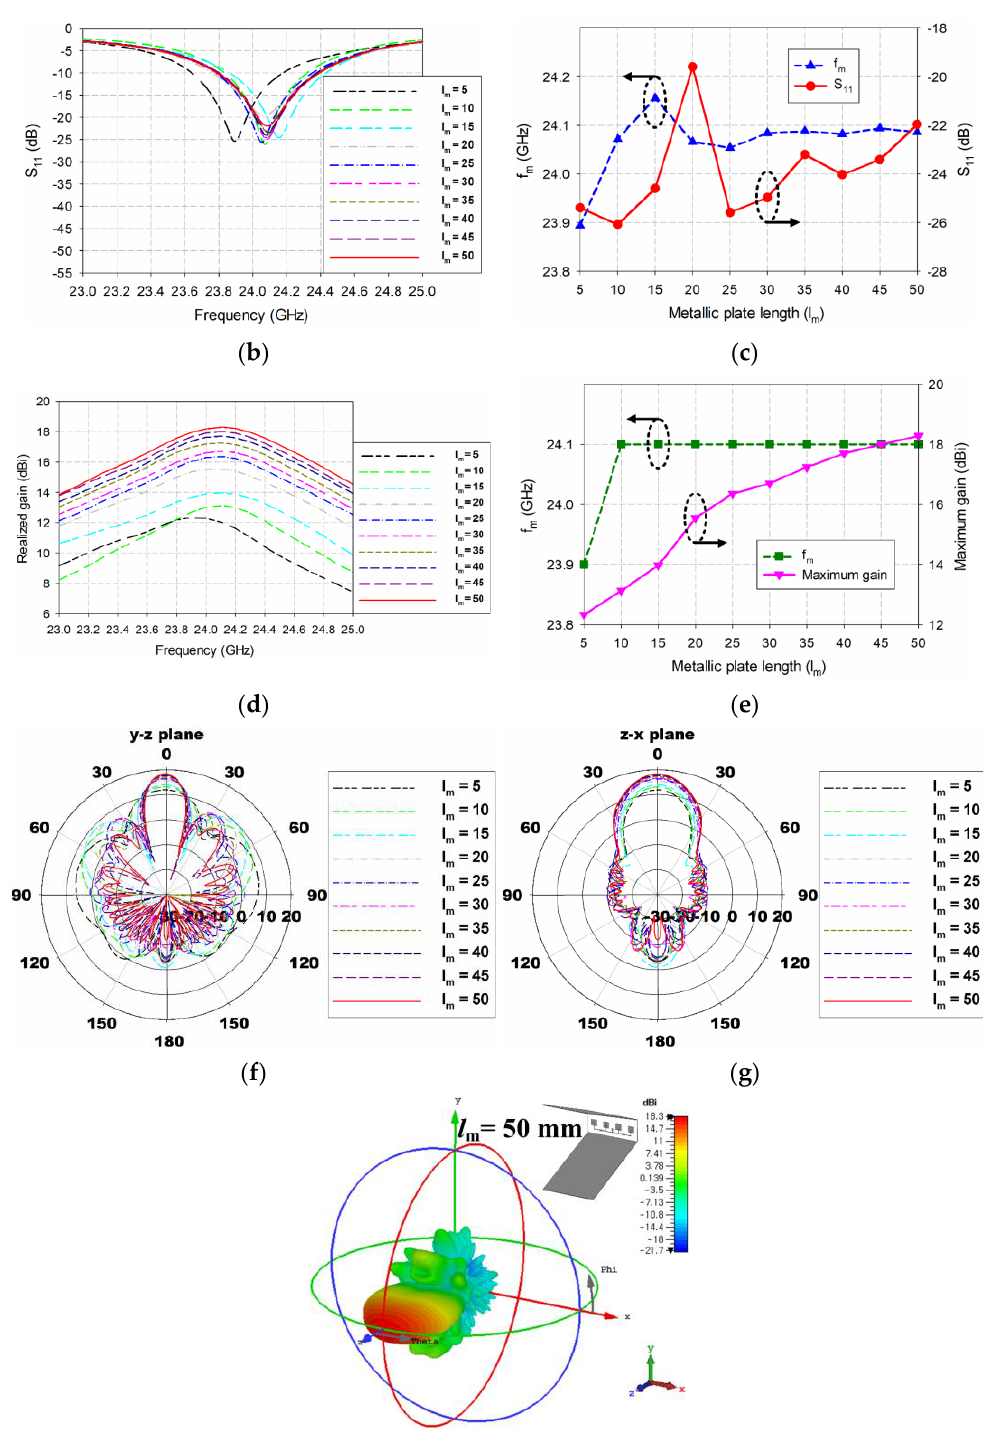
Figure 8. Effects from length l m of the two metallic plates on the 4 × 1 microstrip square patch array antenna when θ = 70 ° : ( a ) the geometry for l m = 50 mm, ( b ) S 11 , ( c ) the frequencies and magnitudes at the minimum of S 11 , ( d ) realized gain, ( e ) the frequencies and values of maximum gain, ( f ) radiation patterns on the y–z plane at maximum gain frequency, ( g ) radiation pattern at z–x planes at maximum gain frequency, and ( h ) the 3D radiation pattern for l m = 50 mm.